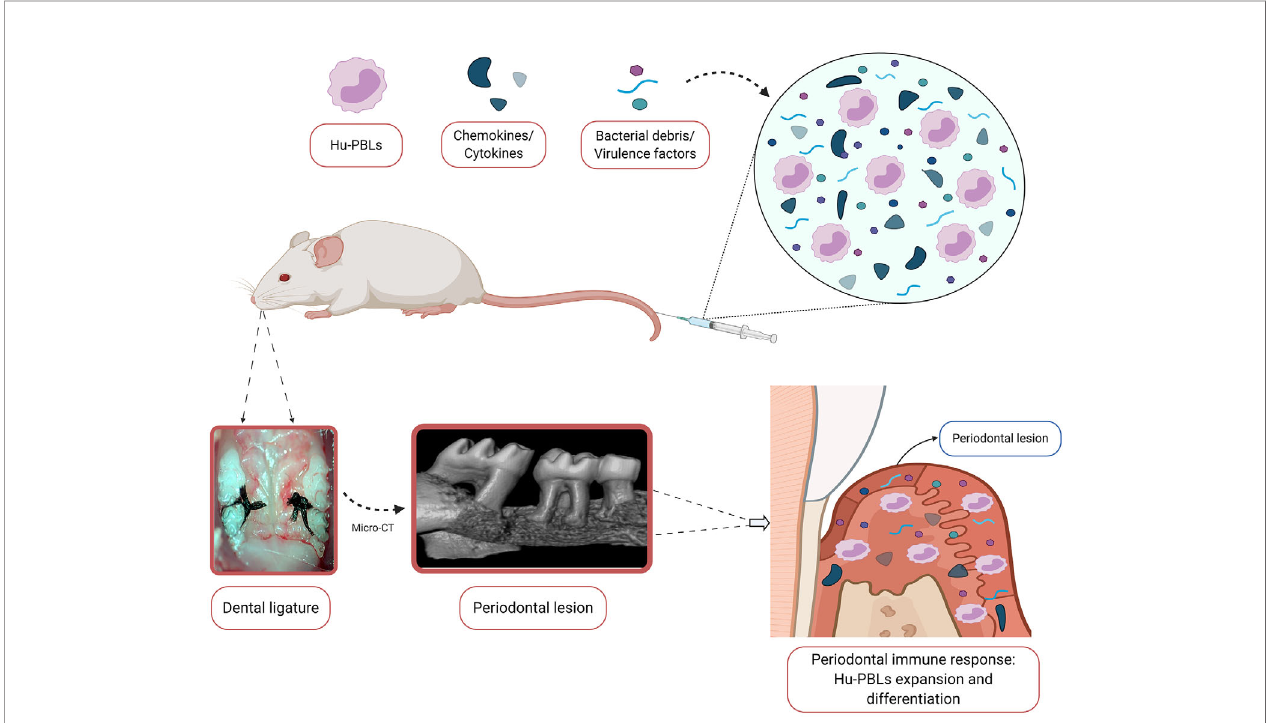
FIGURE 4 | Proposal for a humanized mouse model for the study of periodontitis. The placement of bilateral silk ligatures around the second maxillary molars of hu- PBL-NSG mice provokes local bacteria accumulation, periodontal microbiota dysbiosis, and bacteremia. Consequently, this bacterial insult results in systemic dissemination of antigens, bacterial debris, virulence factors, cytokines, and chemokines. In turn, they are capable of being recognized by the engrafted human peripheral blood mononuclear cells (PBMCs), which ultimately leads to the orchestration of a human-like immune response within the periodontal tissues and lymph nodes that drain them. The resulting local expansion and differentiation of the human PBMCs would lead to the formation of a periodontal lesion, characterized by the presence of a dense in fl ammatory in fi ltrate and alveolar bone resorption. Hu-PBLs, human peripheral blood lymphocytes. Created with